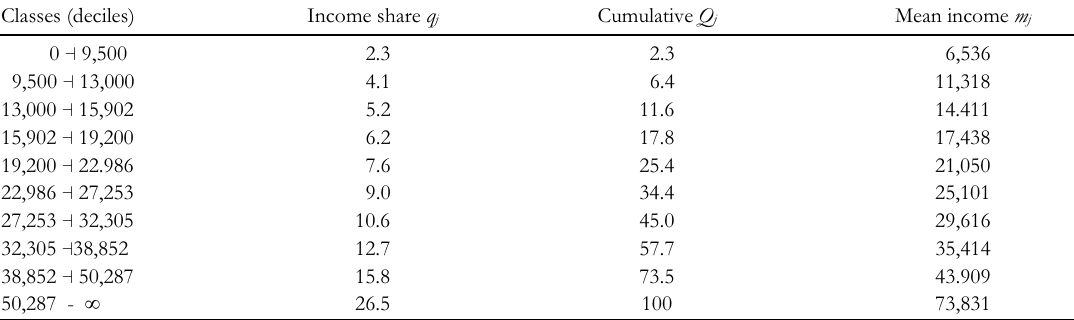
Deciles and income shares for tenths of families (Banca d’Italia Survey, 2002). (Mean income: Euros 27,868)